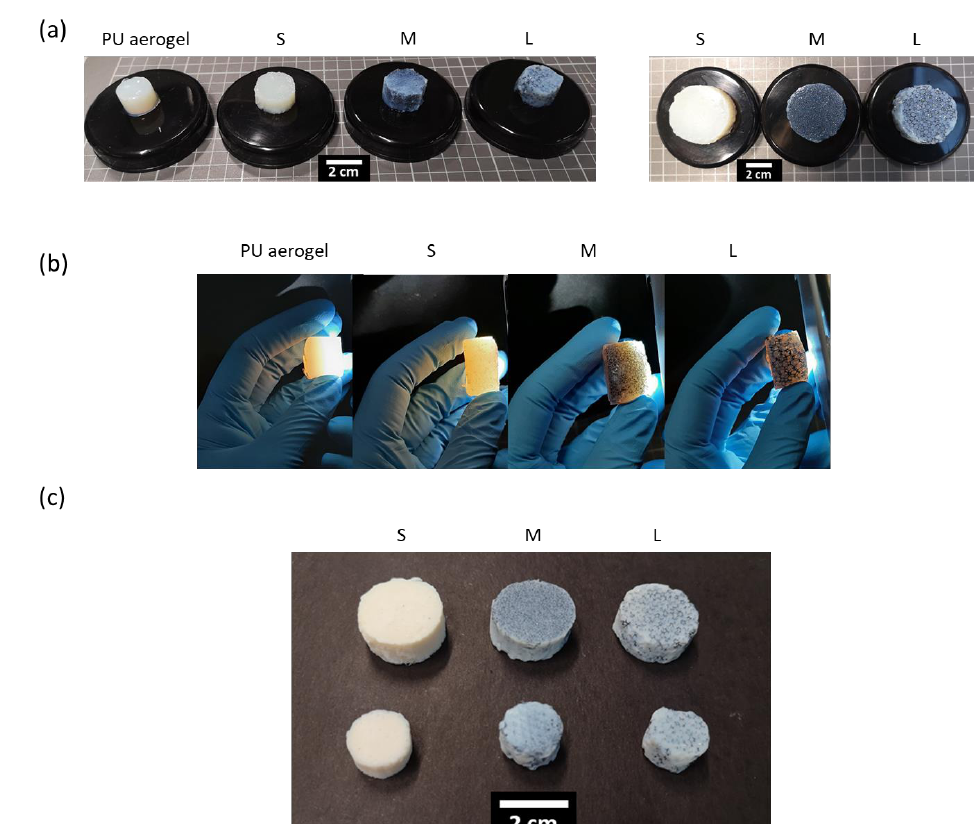
Figure 3. ( a ) PU reference gel and PU F –PU A gels used for the mechanical tests ( left ) and thermal conductivity measurements ( right ). ( b ) Gels’ appearance when a light beam passes through the sample. ( c ) PU F – PU A dried composites.